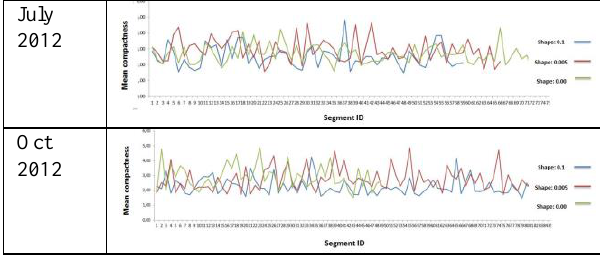
Table 3. Compactness values for the derived segments per TS-X image using different weighting of homogeneity